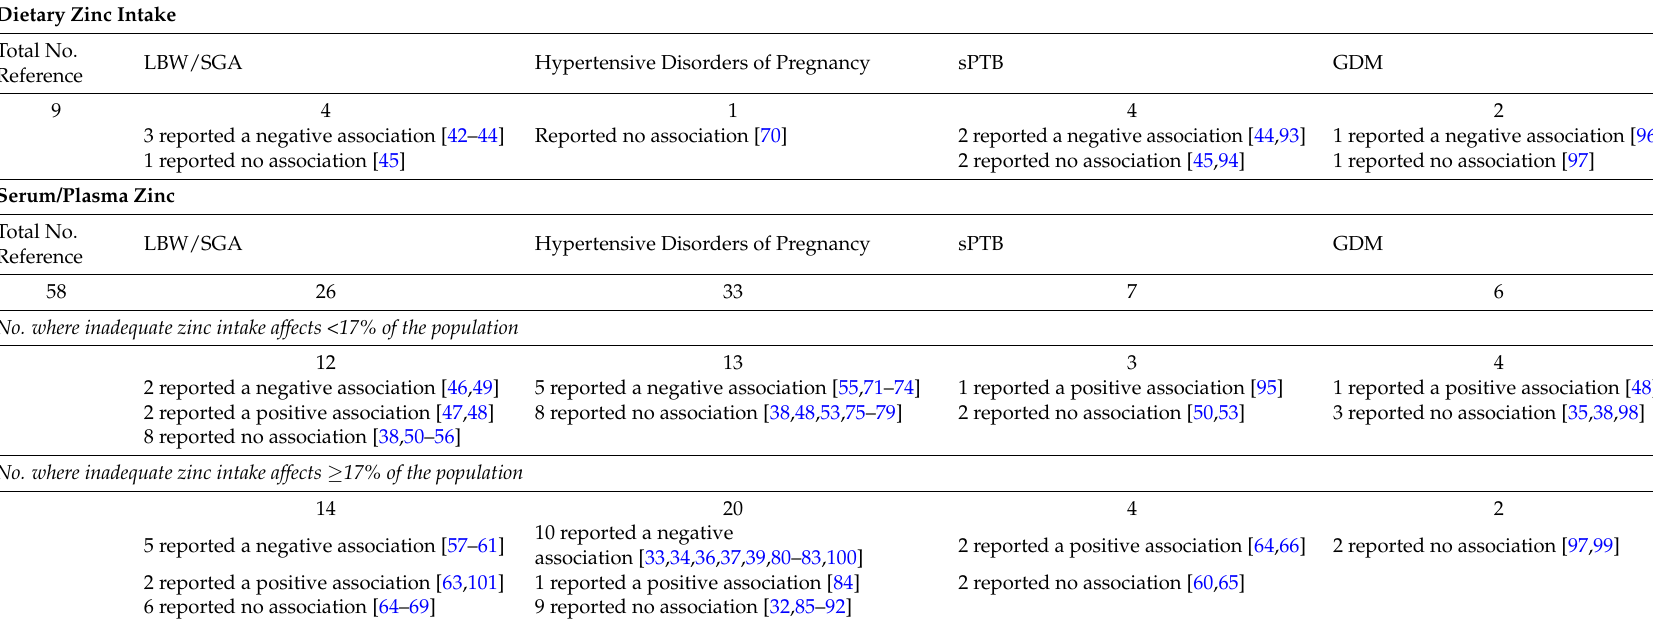
Table 5. Summary of all the studies reviewed and whether zinc status was positively, negatively or not associated with the studied pregnancy complication. Dietary Zinc Intake Total No. Reference